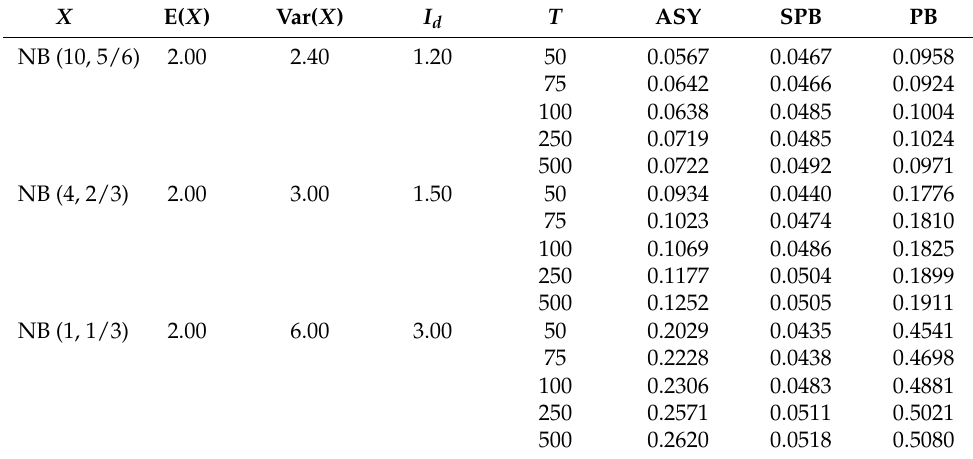
Table 2. Empirical size of the bootstrap-based score test under negative binomial DGP. ASY: asymp- totic, SPB: semiparametric bootstrap, PB: parametric bootstrap.